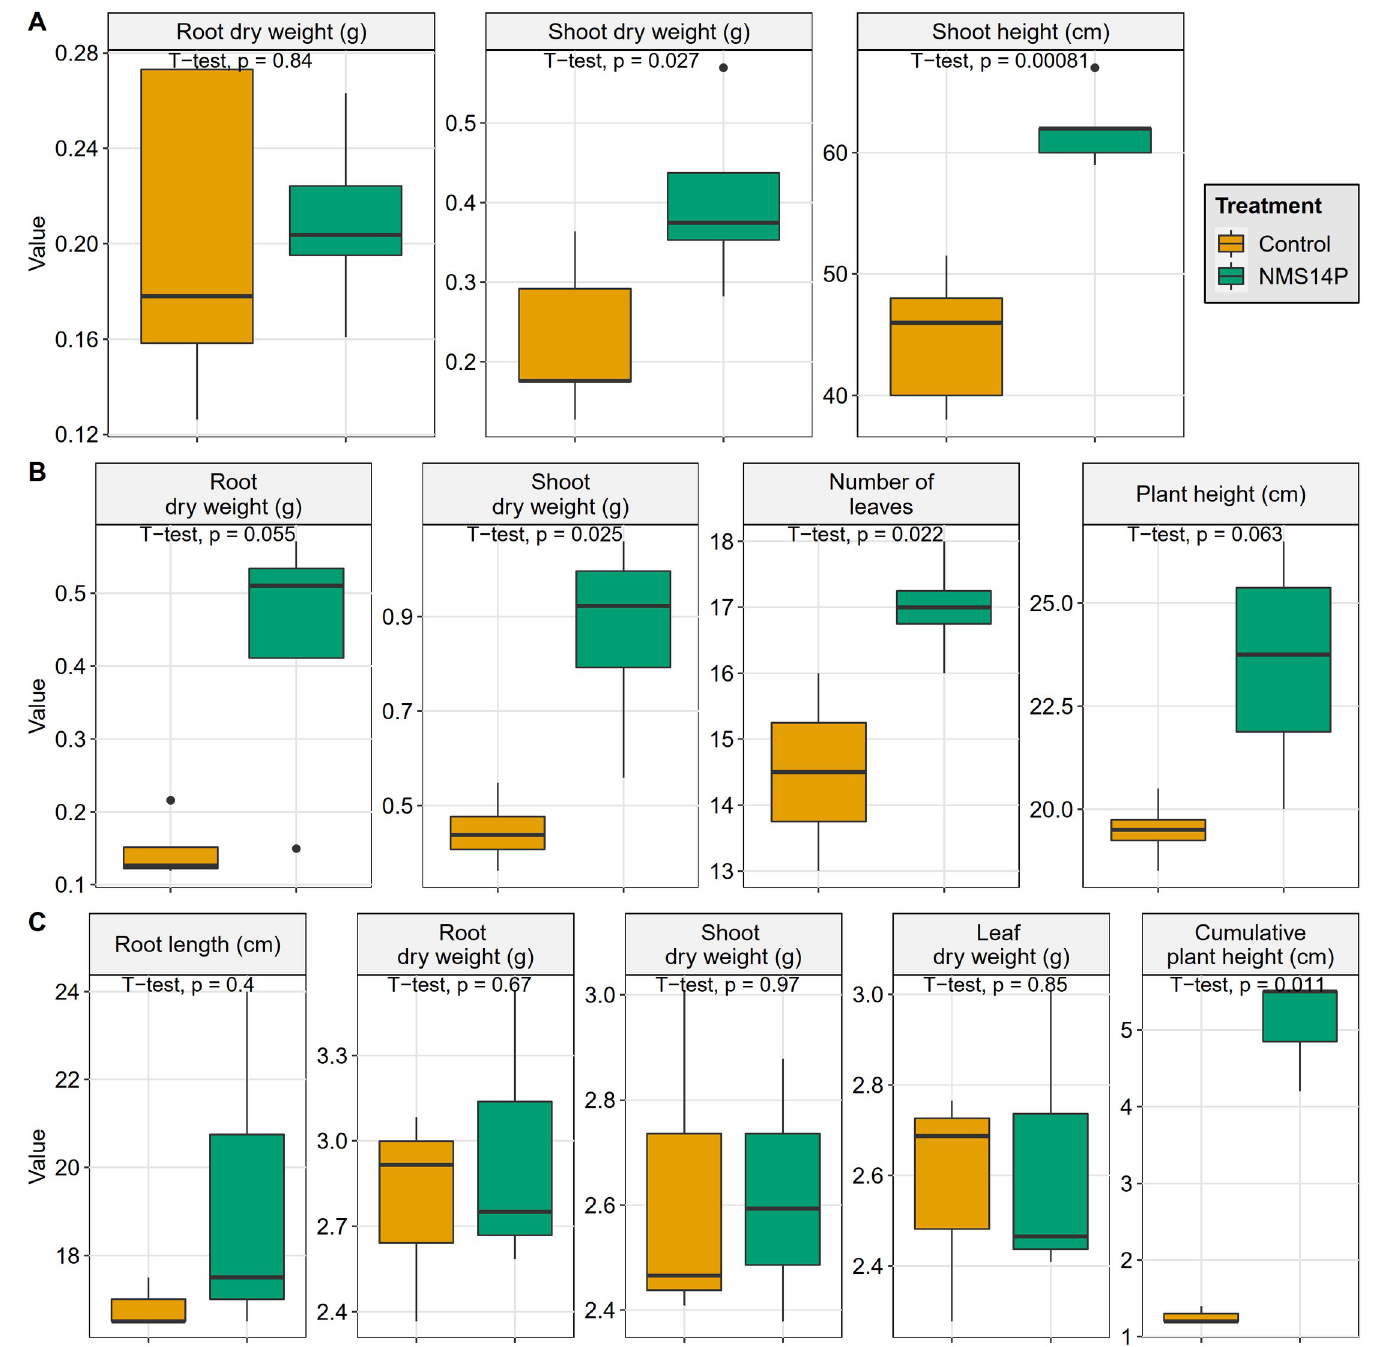
Fig 1. In vivo plant growth-promoting activity test of NMS14P. Greenhouse experiments to evaluate the potential of NMS14P as a PGPB were performed on (A) maize, (B) chili, and (C) sugarcane.